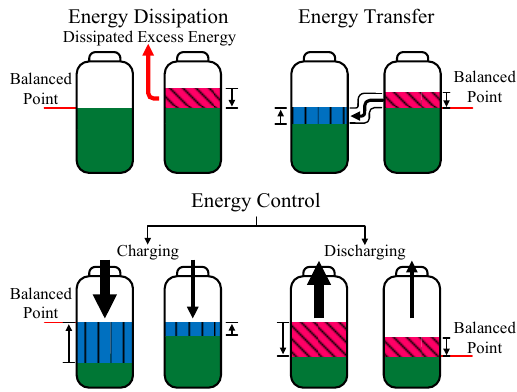
Figure 1. Schematics for energy dissipation, energy transfer, and energy control.